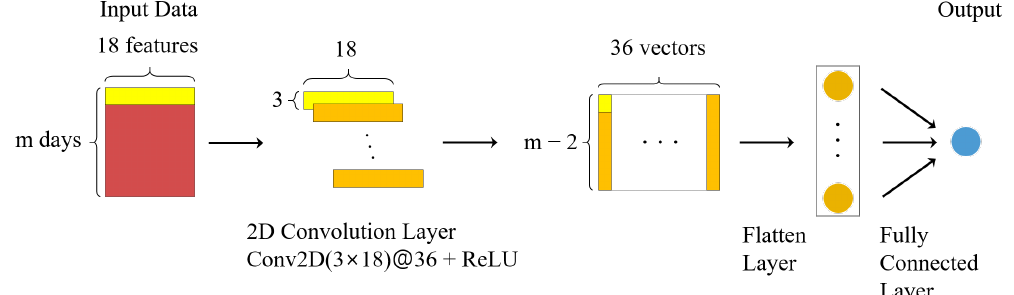
Figure 7. Our CNN model. It consists of a single 2D convolution layer where 36 filters of size 3 × 18 are used for convolution. An m × 18 input matrix is translated into an ( m − 2 ) × 36 matrix by the Conv2D